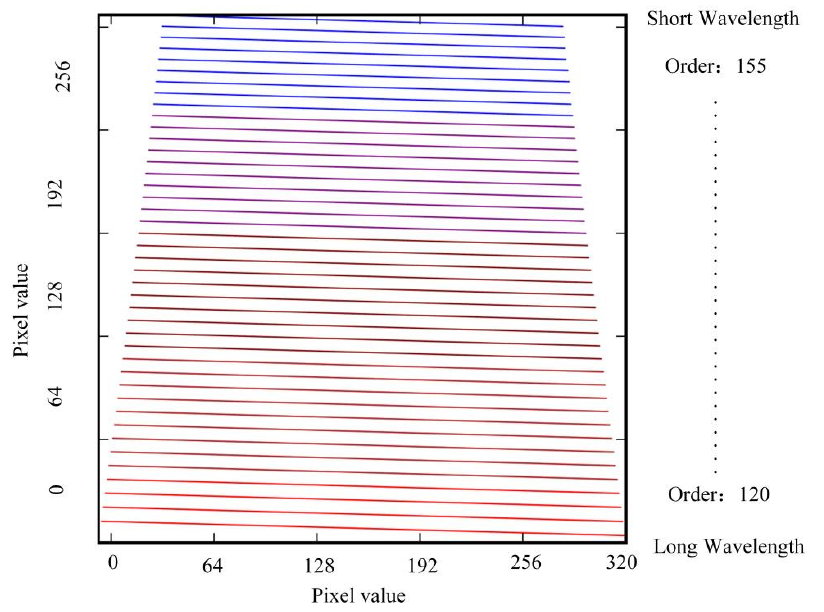
Figure 18. The echellogram shows the free spectral range of 35 orders on a detector of 320 × 256